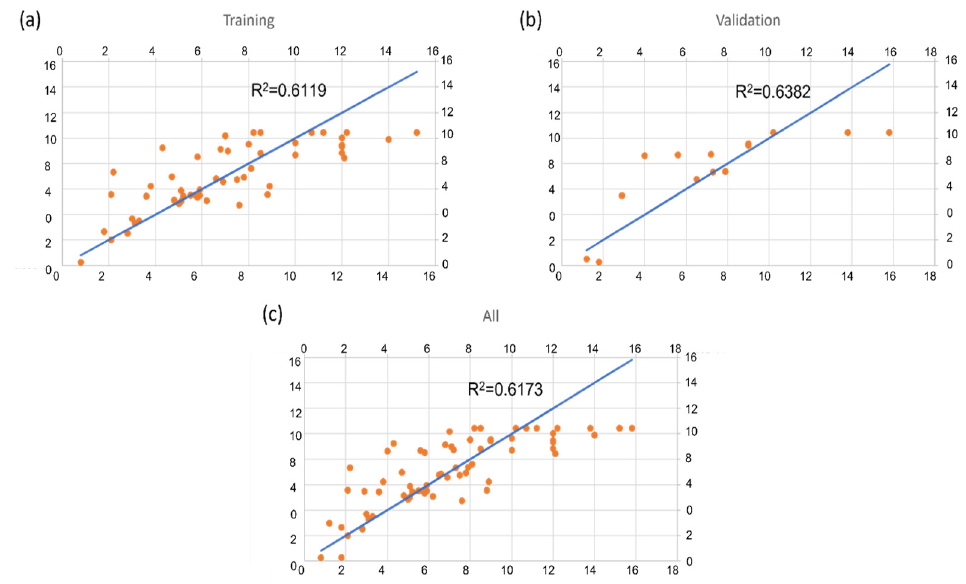
Figure 4. Correlation analysis for regression models for curing time of NCA ( a ) training, ( b ) validation, and ( c ) all.